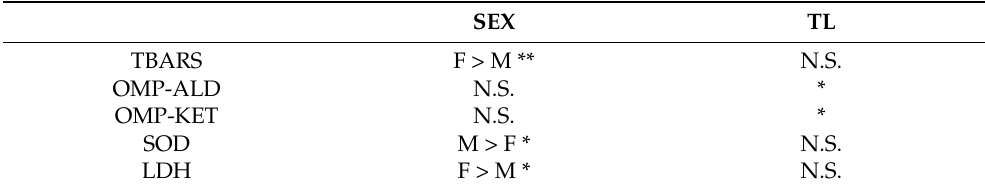
Table 3. Differences in oxidative stress indicators in the muscle of the lesser spotted dogfish S. canicula between sexes and correlation with TL. N.S.—not significant; * p < 0.01; ** p <